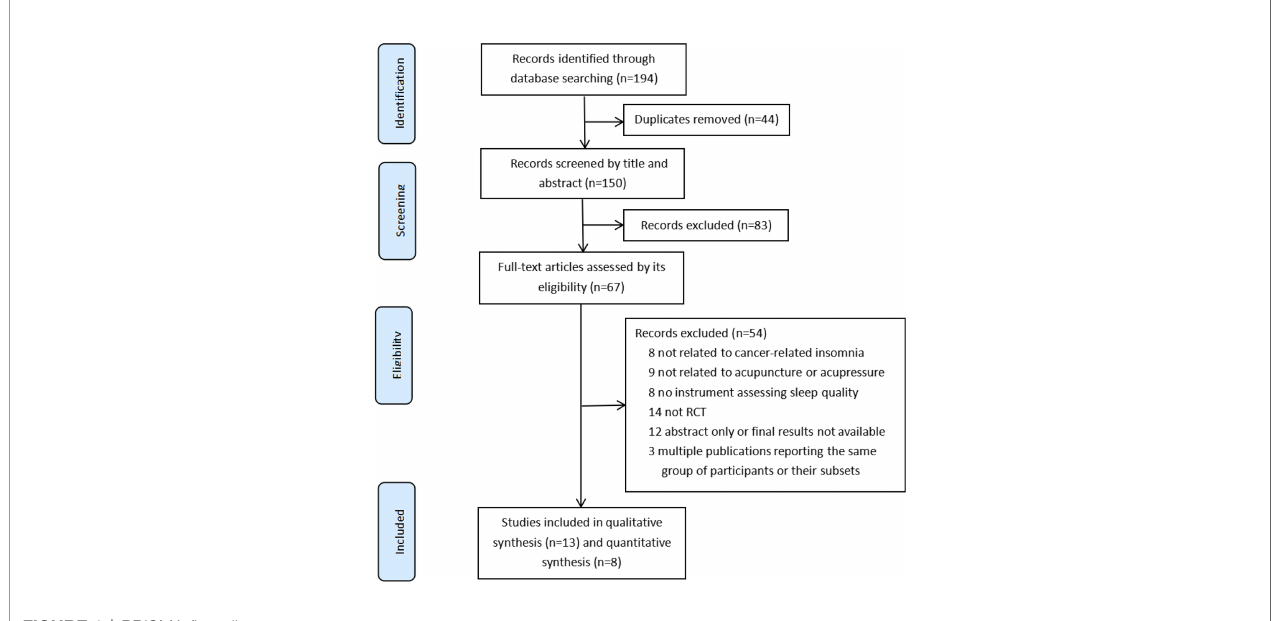
FIGURE 1 | PRISMA fl ow